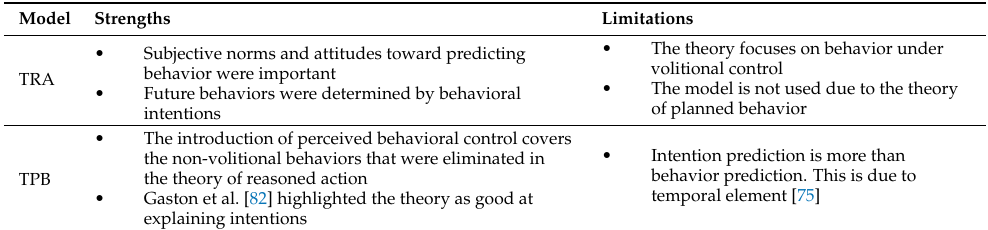
Table 3. Strengths and limitations of cognitive theories: TRA and TPB models. Model